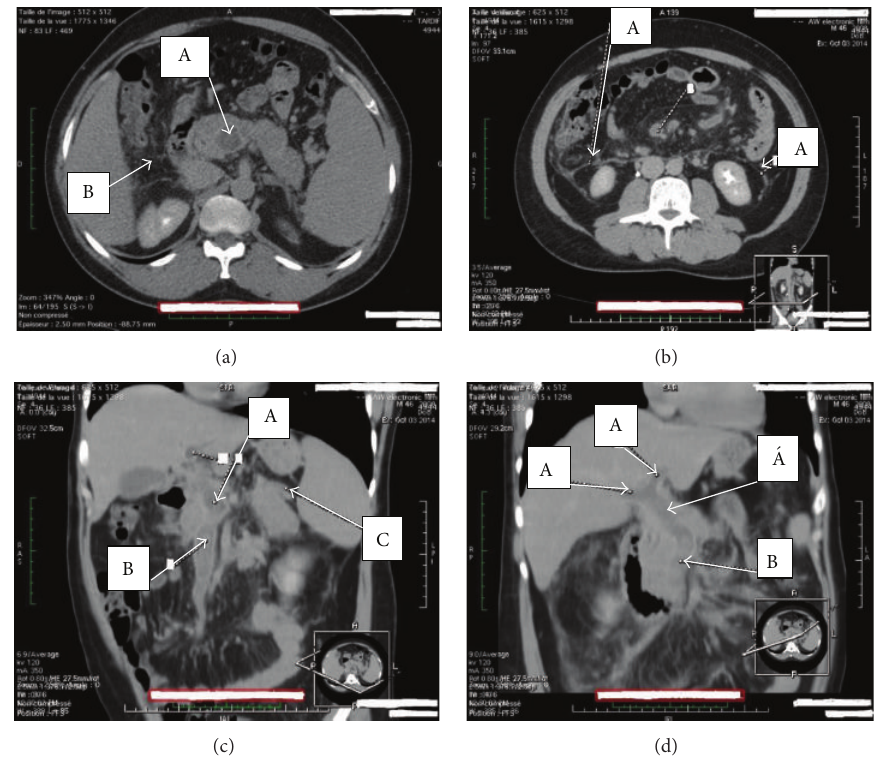
Figure 2: Abdominal contrast-enhanced CT scanner (hospital admission): (a) an edematous pancreas in (A) the superior mesenteric vein thrombosisand(B)theinfiltrationoftheperipancreaticfat.(b)(A)Inflammatoryflows.(c)(A)Theportalvenousthrombosis,(B)thesuperior mesenteric venous thrombosis, and (C) the splenic venous thrombosis. (d) (A) The thrombosis of the left and right branches of the portal vein and (B) the superior mesenteric venous thrombosis and distal branches. Light Speed CT-16 (GE Medical Systems, USA). Contrast: iobitridol 300 mg/mL (Xenetix, Guerbet, Roissy CDG Cedex, France). With the permission of the Cathedral Medical Center (CMC), Yaound´e.